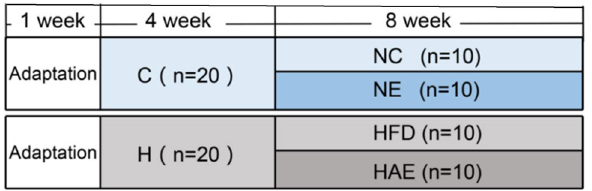
Figure 1. Animal groups Abbreviations: NC, normal control group; NE,normal aerobic exercise group; HFD, high-fat diet group and HAE, high-fat diet with aerobic exercise